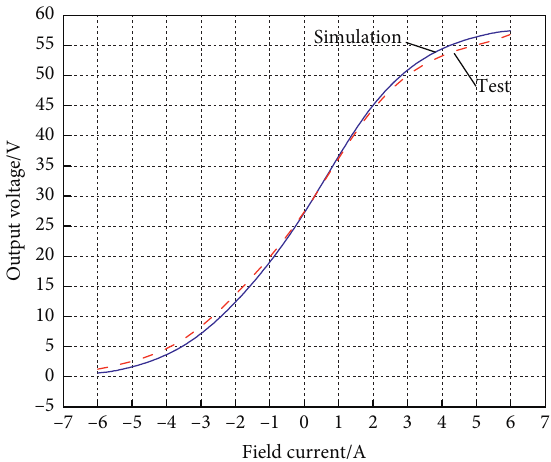
Figure 20: No-load characteristics of the PMCHEG.